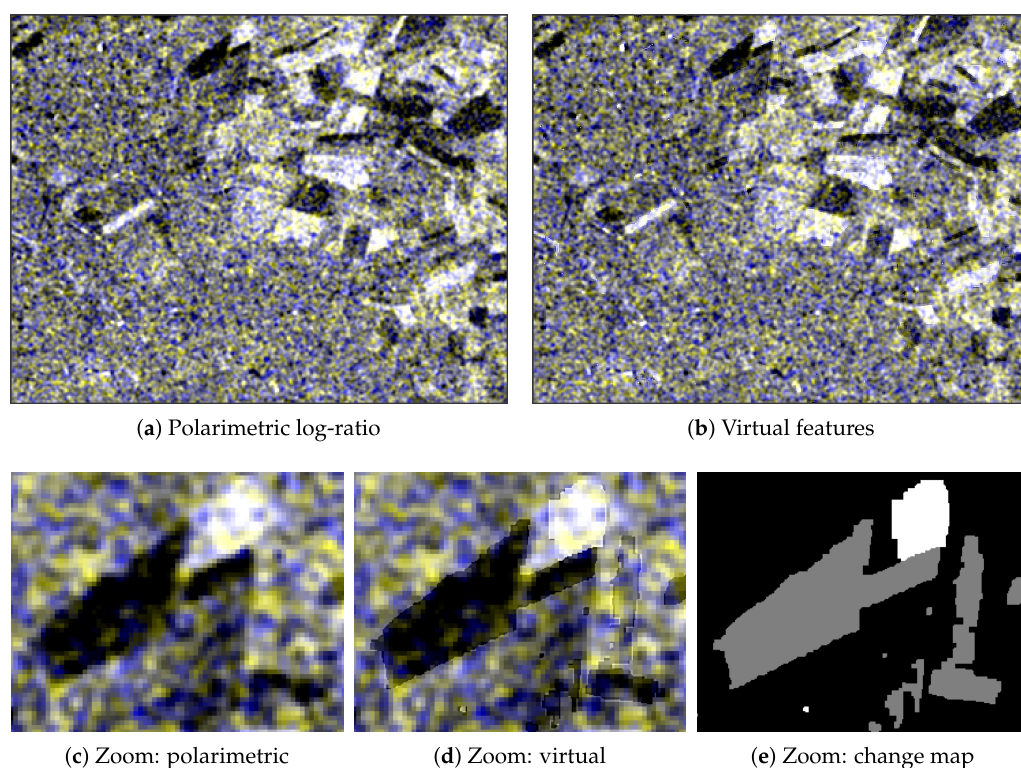
Figure 11. Visual comparison between ( a ) the virtual features and ( b ) the log-ratios of the polarimetric channels upsampled to the stripmap lattice. ( a – d ) are RGB false color representations in which R = G = HH and B = VV. ( c – e ) show details of the polarimetric log-ratio ( c ), the virtual features ( d ), and the change map obtained at the convergence of the proposed method ( e